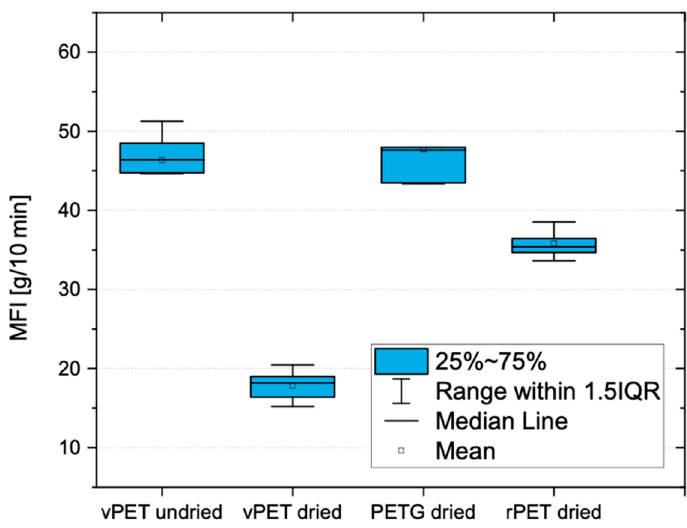
Figure 6. Results of the Standard Test Method for Melt Flow Rates. Table 3. Median line of the results of the MFI on Figure